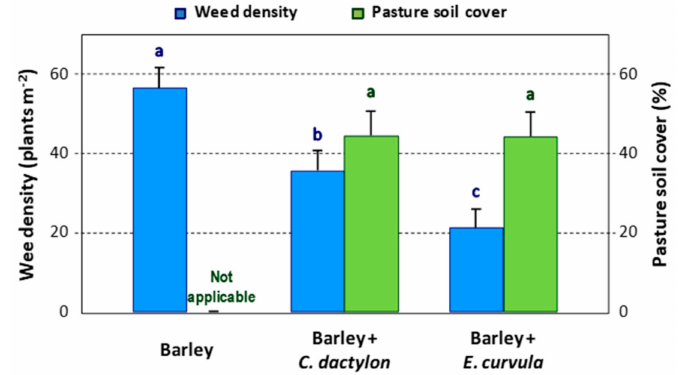
Figure 1. Weed density and pasture soil cover in the three treatments in 2019 in Study 2.